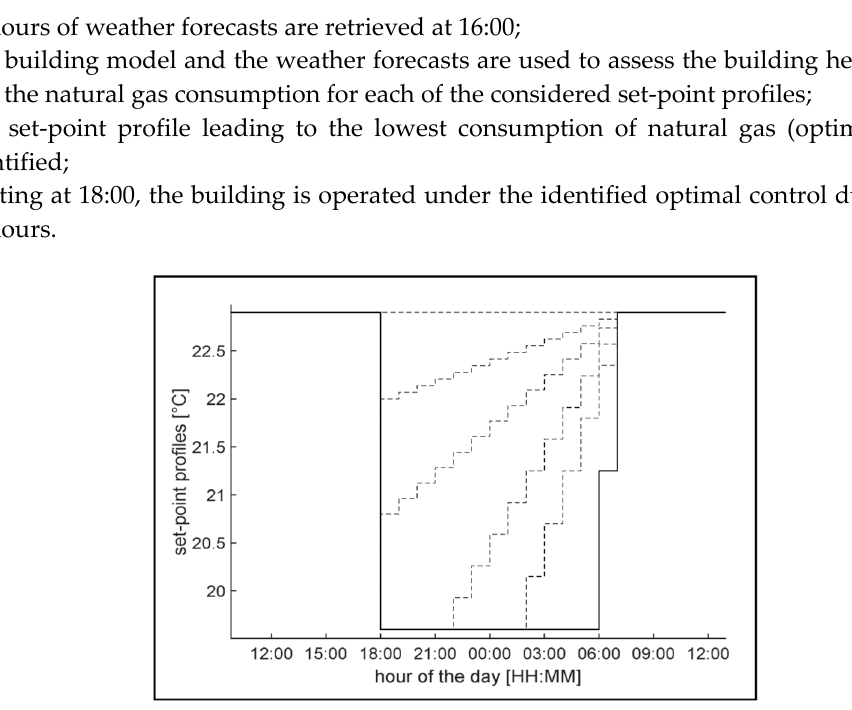
Figure 2. Examples of the considered set-point profiles for reducing the natural gas consumption.